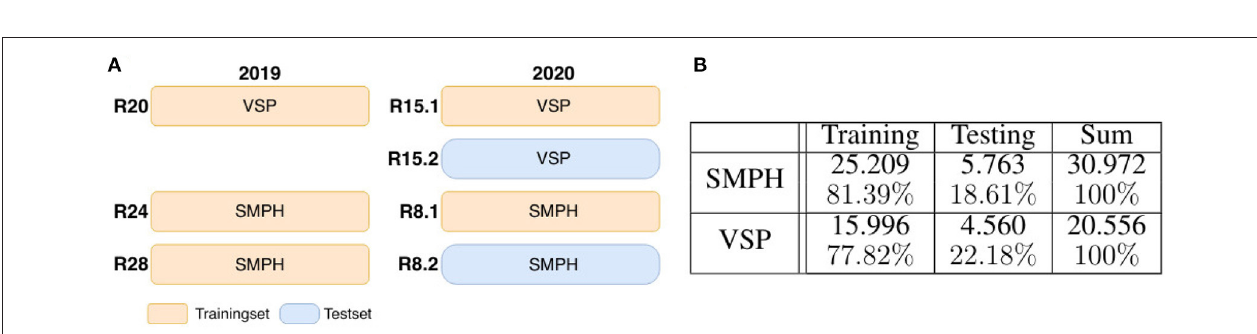
FIGURE 6 | Dataset composition. (A) Shows the visual division of training and test data for the two data sets semi minimal pruned hedge (SMPH) (see Figure 3C ) and vertical shoot positioned system (VSP) (see Figure 3F ) which were collected in the years 2019 and 2020. The data sets are taken from different rows R. Each row corresponds to one of the two sets. In 2020 the same rows were run twice. Once left (R15.1 and R8.1) and once right (R15.2 and R8.2) of the row. Orange marked areas are used for training, blue marked ones for testing. The table shown in (B) indicates the corresponding numbers of training and test data patches.